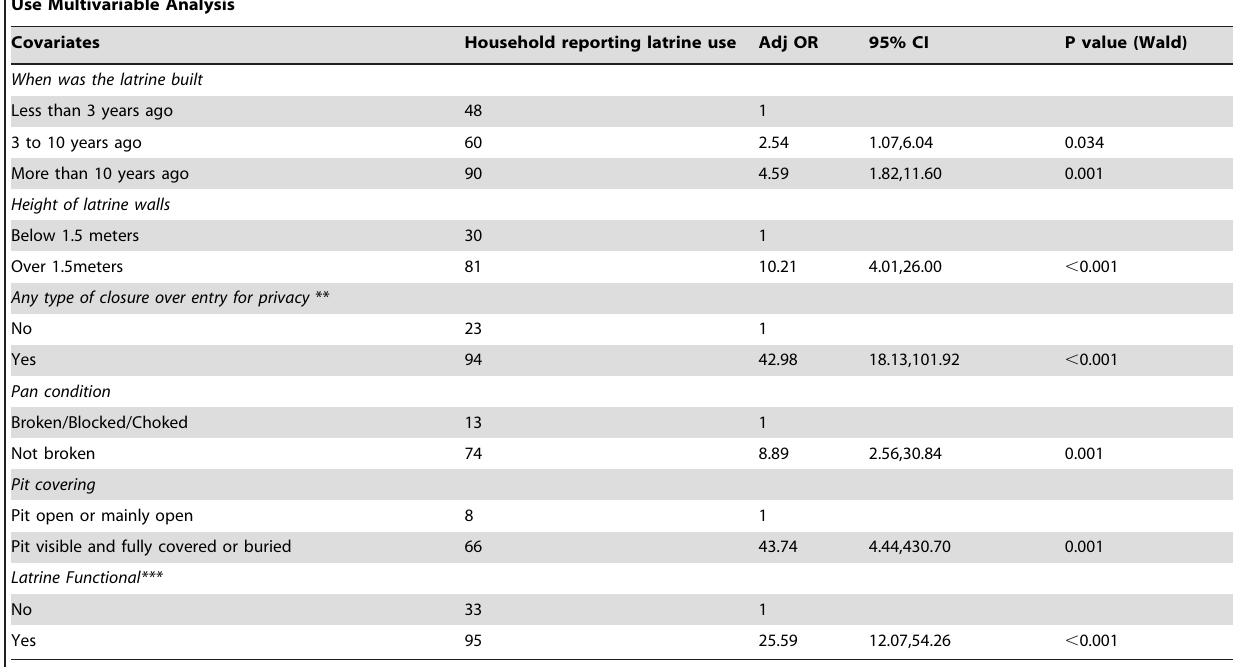
Table 5. Multivariable regression analysis of factors associated with latrine